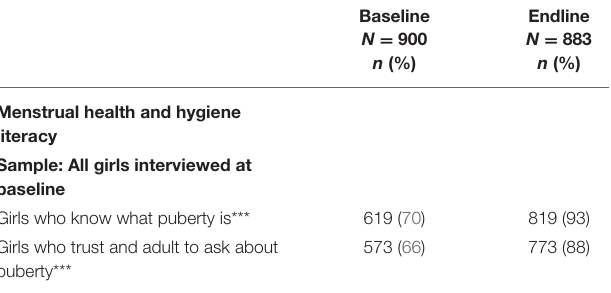
TABLE 7 | Changes in MENSES Outcomes between baseline and endline by